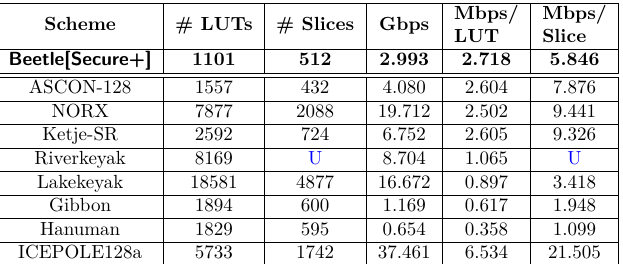
Table 8: Benchmarking Beetle[Secure+] on Virtex 7. We use U to denote that the corresponding results are